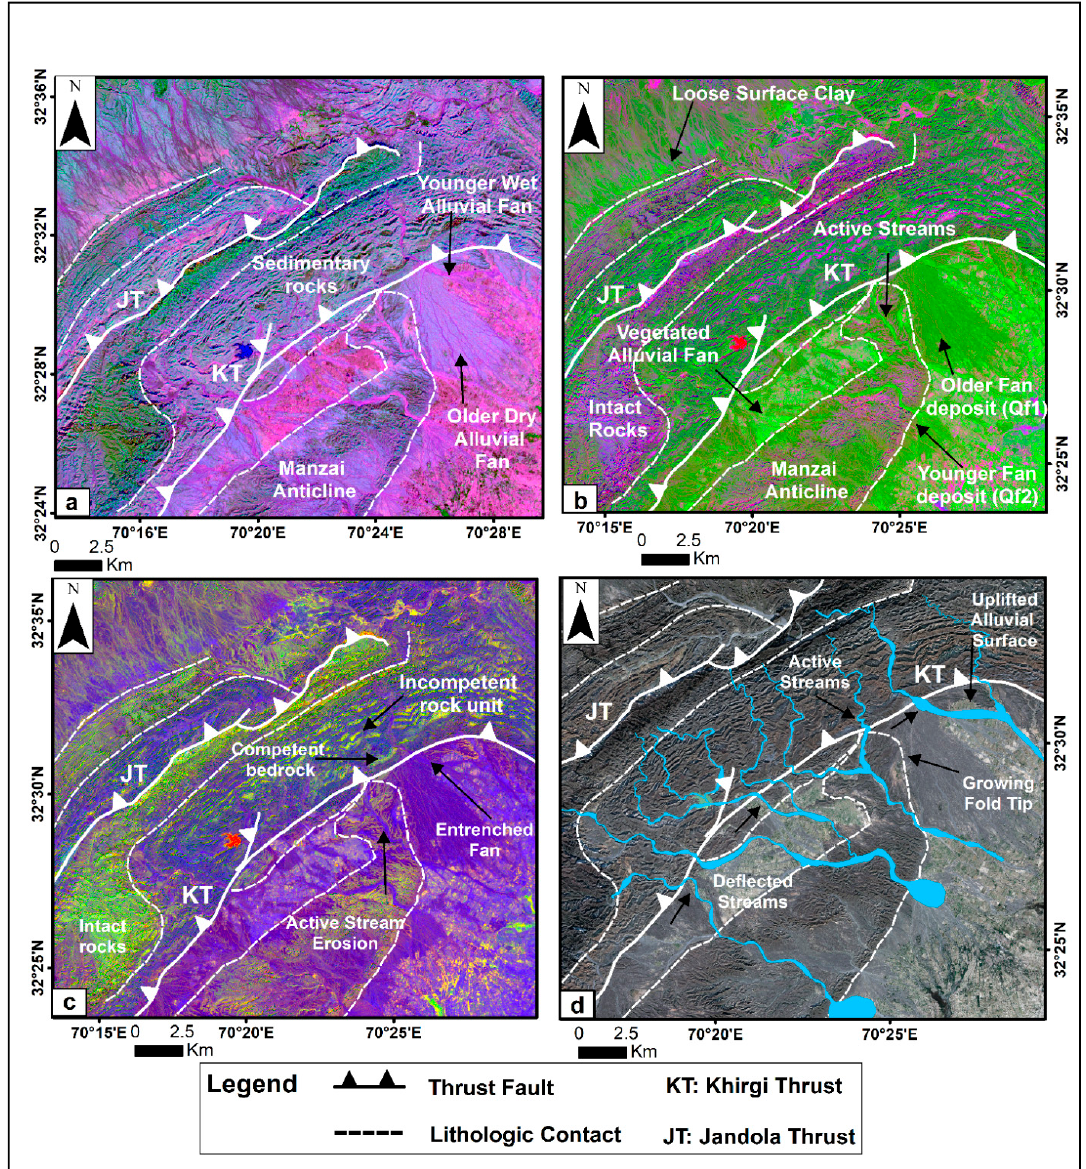
Figure 3. Sentinel-2B band ratios ( a ) 12/7-12/3-12/11; ( b ) 11/12-12/7-8/11; ( c ) 8/11-11/12-12/7 displayed as a RGB composite to discriminate lithology and structural elements. The interpreted lithologic units correlate well with the previously mapped units. The band ratios in ( a ) differentiate younger wetter alluvial fans from older drier alluvial fans based on hydroxyl ion (OH − ). The older drier alluvium appears in light blue, while the younger wetter one appears in plum color. The light pink color shows the vegetation on the fan. The band ratios in (b) and (c) discriminate the different types of sedimentary rocks based on the clay content and surface texture. In ( b ), the violet color shows intact and homogenous sedimentary rock type, and the light green color represents the loose surface clays within active streams entrenching the older drier alluvial fans. While ( c ) shows more heterogeneous lithology in the form of interbedded competent yellow-green sandstone and incompetent dark blue clays in the hanging wall of Khirgi Thrust, the yellow color depicts the Manzai anticline actively growing into the older alluvial fan; ( d ) Sentinel-2 true color composite (RGB: 432) showing streams deflection in an actively evolving fold–thrust belt.